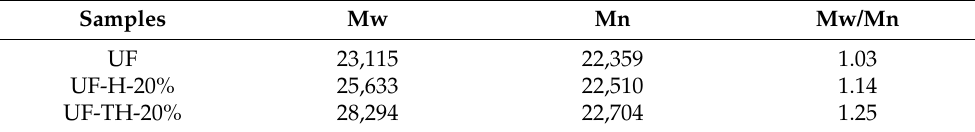
Table 1. The molecular weights and molecular weight distribution of UF and UF/HNTs nanocomposites.